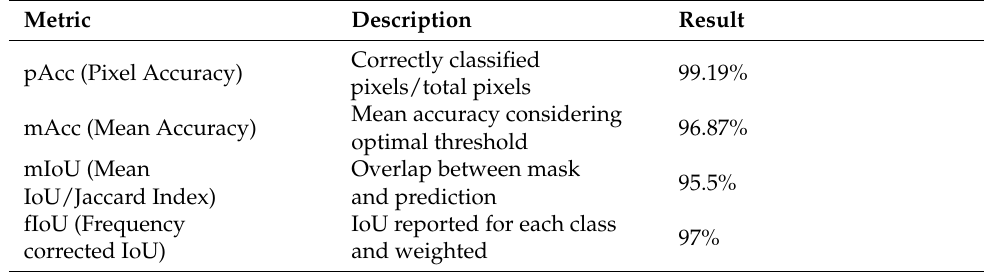
Table 2. Results—key performance metrics of the